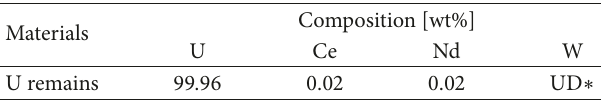
Table 3: Chemical composition of U-dendrite remains after salt distillation